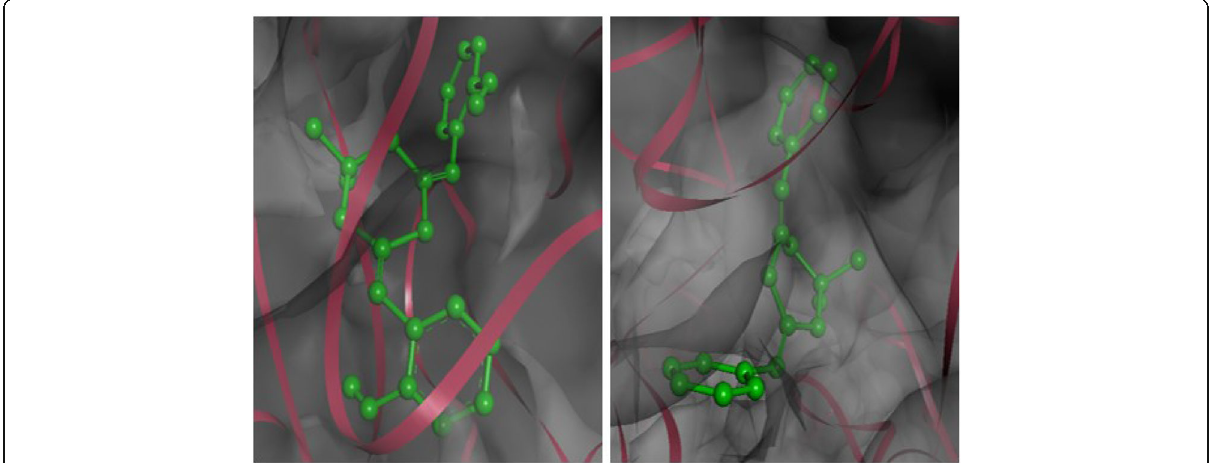
Fig. 3 3D interaction diagrams of a DmChDp in site 3 of 2W9S and b DmChDa in site 2 of